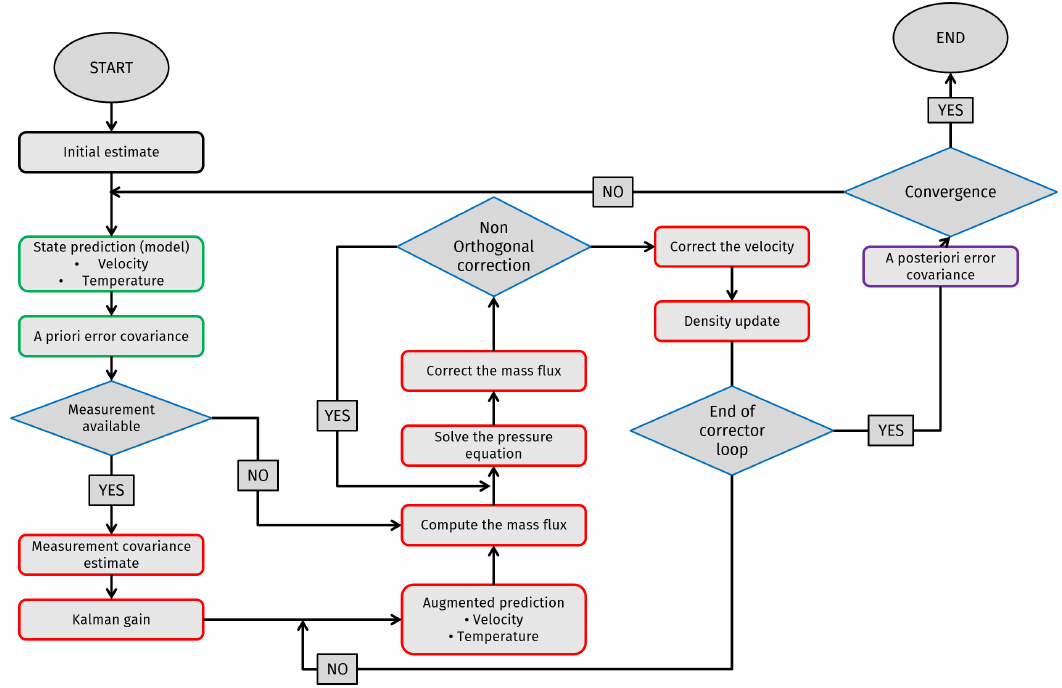
Figure 1. Flow chart of the integrated algorithm. The blocks with blue borders represent the prediction step, the ones with red borders are the corrector step, and the purple borders highlight the regularization